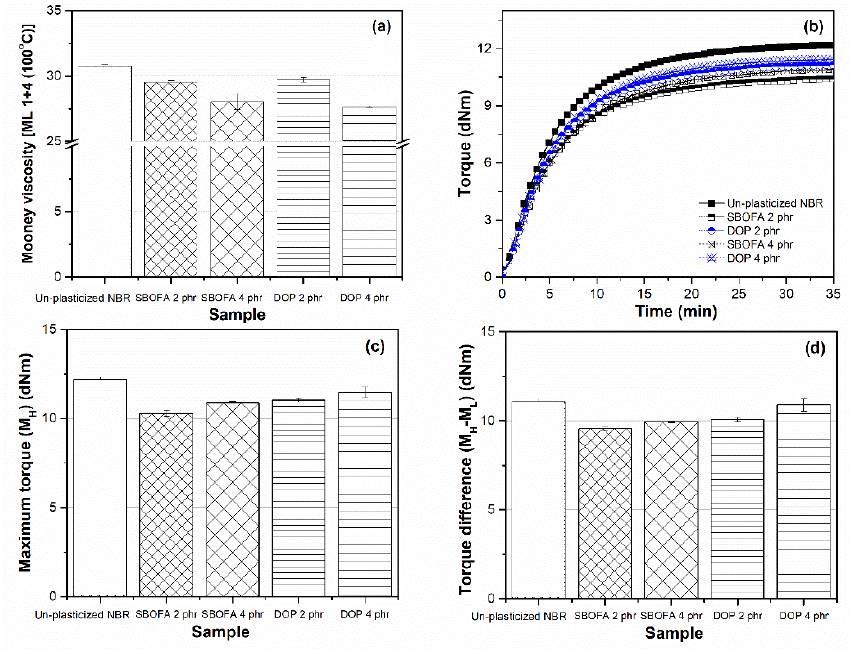
Figure 14. The ( a ) Mooney viscosity; ( b ) cure characteristic; ( c ) maximum torque (M H ), and ( d ) torque difference (M H -M L ) of unplasticized NBR and NBR vulcanizates with 2 and 4 phr of SBO and DOP. Data are shown as the mean ± 1SD, derived from three experiments. Table 11. Cure parameters and crosslink density of unplasticized NBR and NBR vulcanizates with 2 and 4 phr loadings of SBO and DOP. Cure